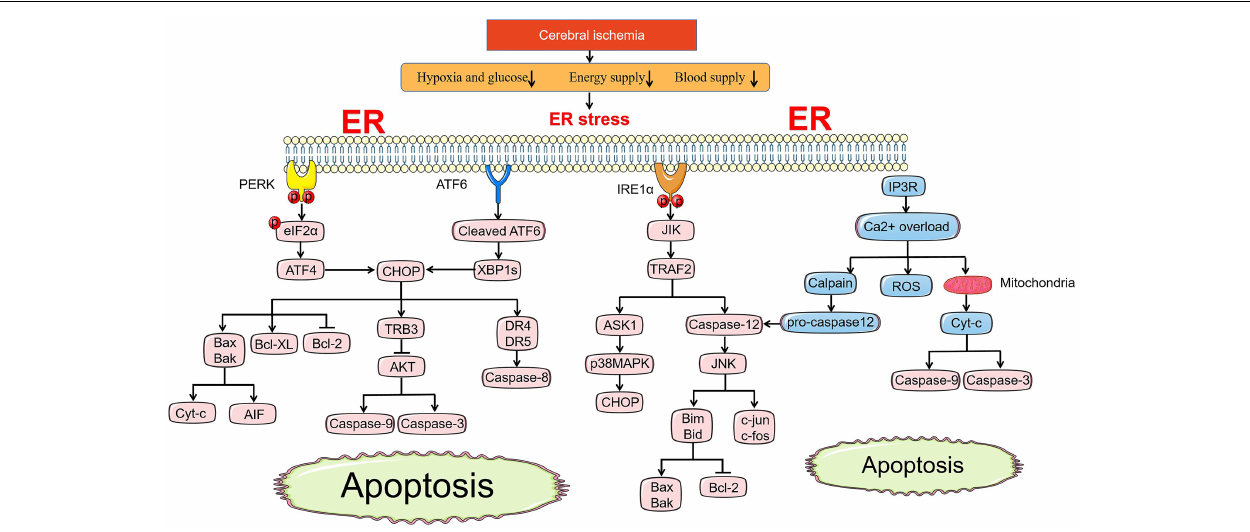
FIGURE 2 | ER stress-mediated apoptosis pathway under cerebral ischemia. Under ischemic state, PERK and ATF6 both involve in apoptosis pathways induced by CHOP. BCL family, TRB3-AKT axis and death receptor DR4/5 are all regulated by CHOP to promote the release of Cyc-c and AIF, active the caspase-9, caspase-3, and caspase-8, respectively. JIK-TRAF2 apoptosis pathway induced by IRE1 α and Ca 2 + overload promote the activation of caspase-12, which accelerates the pro-apopotic protein of BCL family by controlling JNK. Ca 2 + overload leads to the release of ROS directly and Cyt-c indirectly activating caspase-9 and caspase-3 via cross-talk with